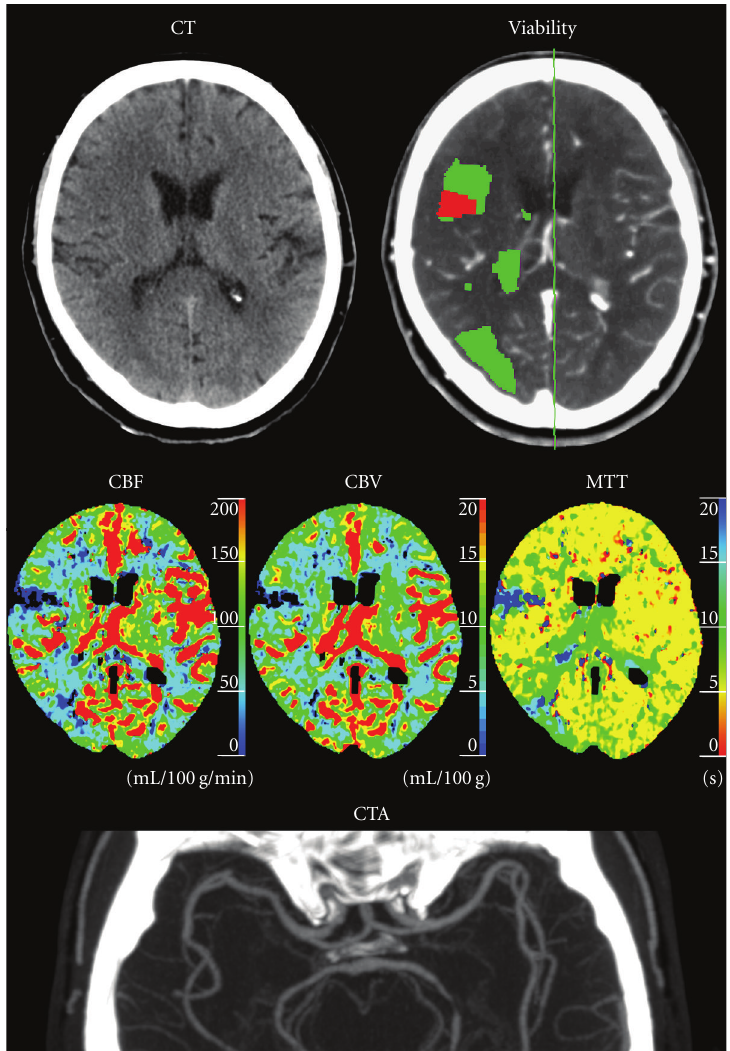
Figure 5: Case 2: 65-year-old male left-sided stroke symptoms and a normal NECT. The CTP viability map shows multiple perfusion defects (green) and a small area of advanced perfusion deficit (red) in the right hemisphere consistent with fragmented cardiogenic embolism. The CTA showed no major arterial occlusion obviating neurointervention.